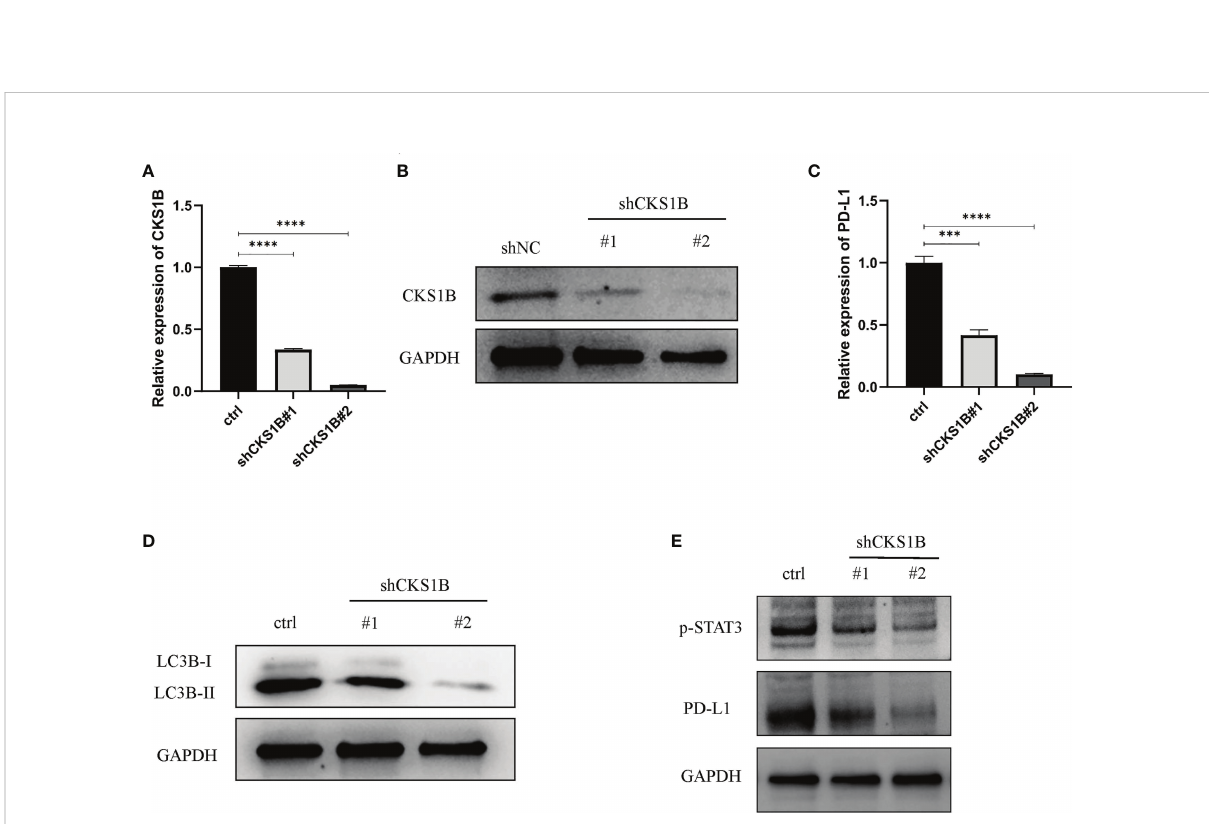
FIGURE 8 Knocking down CKS1B inhibits autophagy and STAT3/PD-L1 signaling in PC cells. (A, B) mRNA and protein expression of CKS1B in cells transfected with shCKS1B. (C) mRNA expression of PD-L1 was measured by qRT-PCR. (D) Protein levels of LC3B were measured by Western blotting. (E) Protein levels of p-STAT3 and PD-L1 were measured by western blotting. (***P<0.001,****P<0.0001).